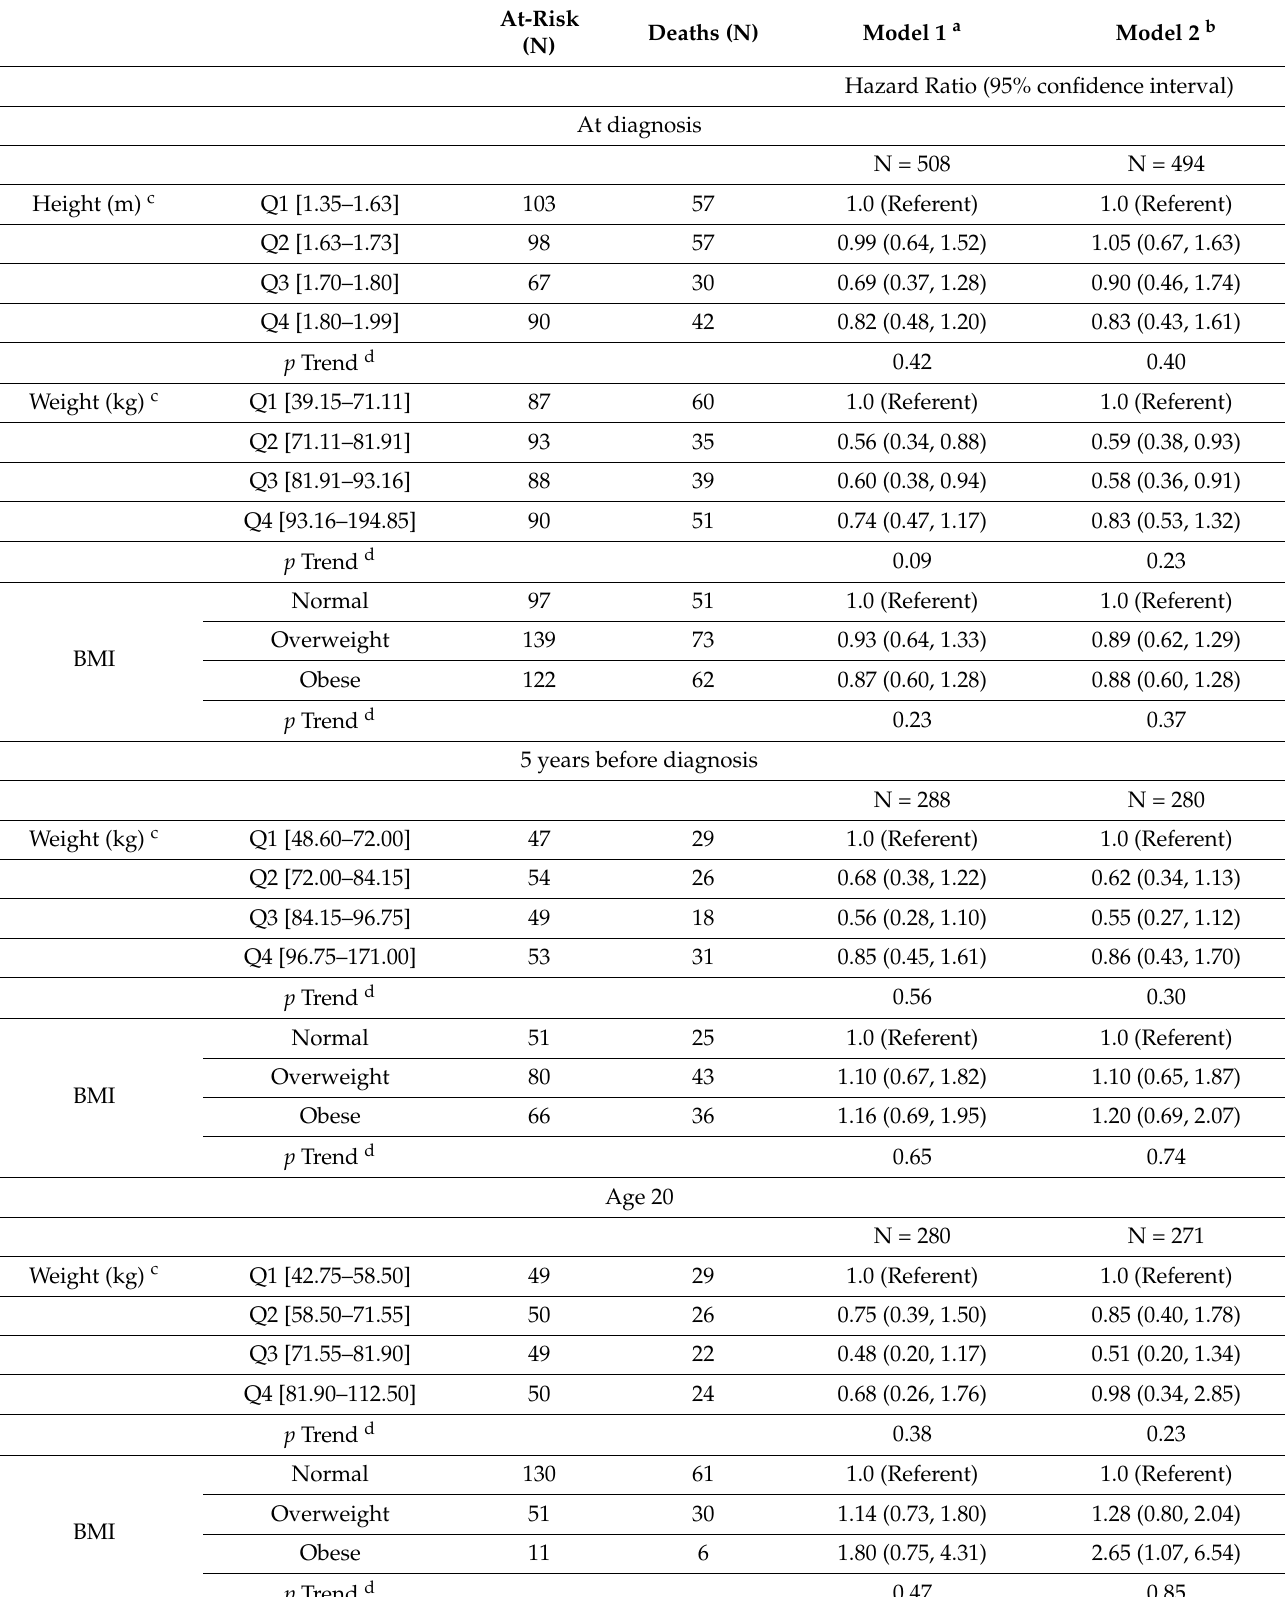
Table 2. Associations between height, weight, and body mass index (BMI) at multiple myeloma (MM) diagnosis and pre-diagnostic BMIs with overall survival among patients with